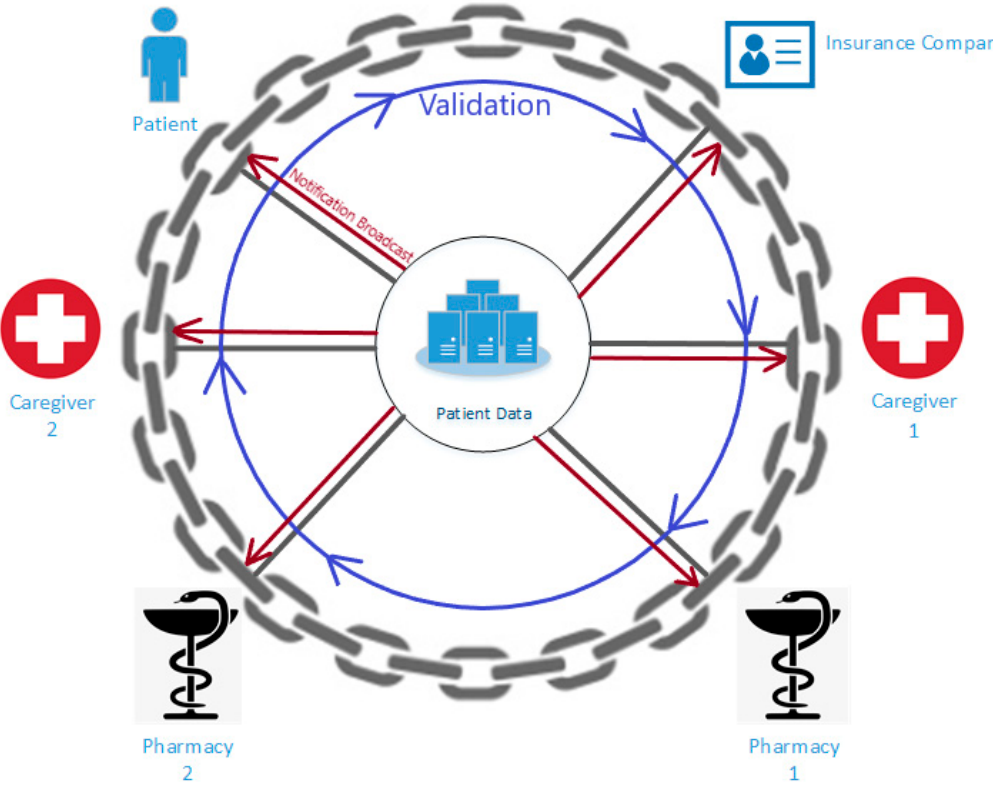
Figure 2. Healthcare blockchain conceptual model.